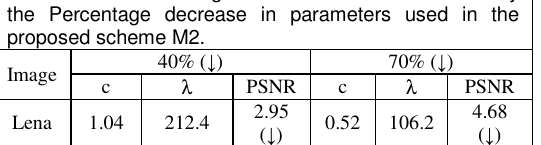
Table 6: The Percentage effect on The PSNR values by the Percentage decrease in parameters used in the proposed scheme